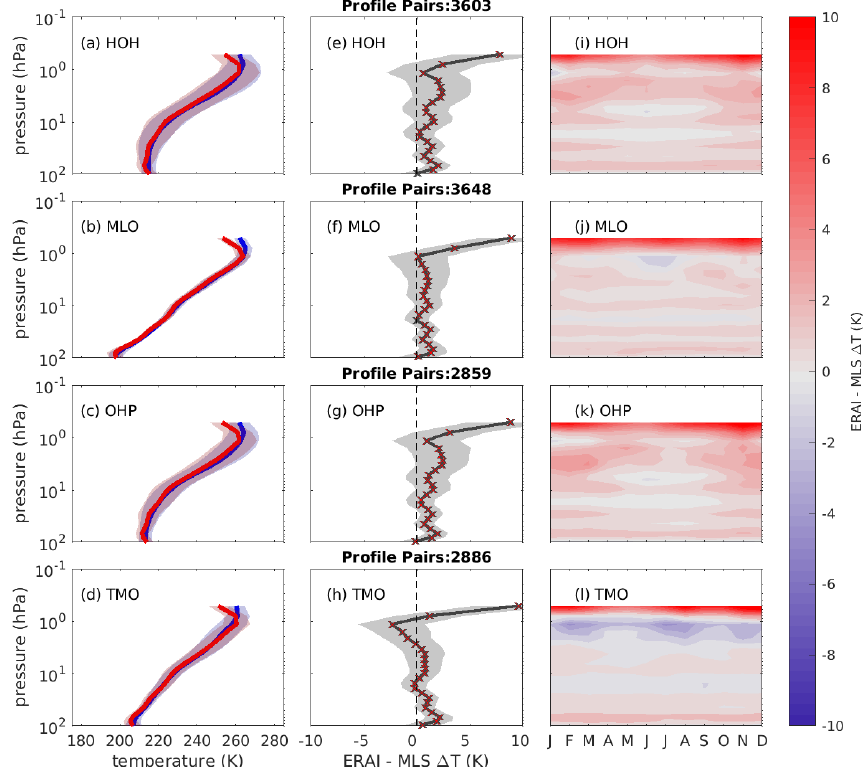
Figure 3. Mean profiles of matched temperatures from ERA-Interim (blue) and EOS MLS passes (red) at (a) Hohenpeissenberg, (b) Mauna Loa, (c) Observatoire de Haute-Provence and (d) Table Mountain Observatory between 1990 and 2017. Shading depicts 1 standard deviation in the mean temperature. The vertical profiles of the mean of the differences between ERA-Interim and EOS MLS shown in (a–d) are shown in (e–h) respectively; shading shows 1 standard deviation of mean difference. Crosses are red for model levels where the mean of the differences are different from zero at the 95% significance level. Panels (i–l) show the temperature differences as a function of month and pressure level for each of the lidars shown in panels (a–d)